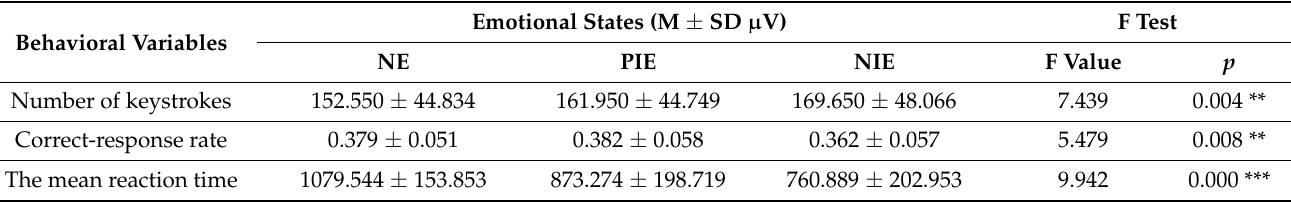
Table 1. The behavioral data